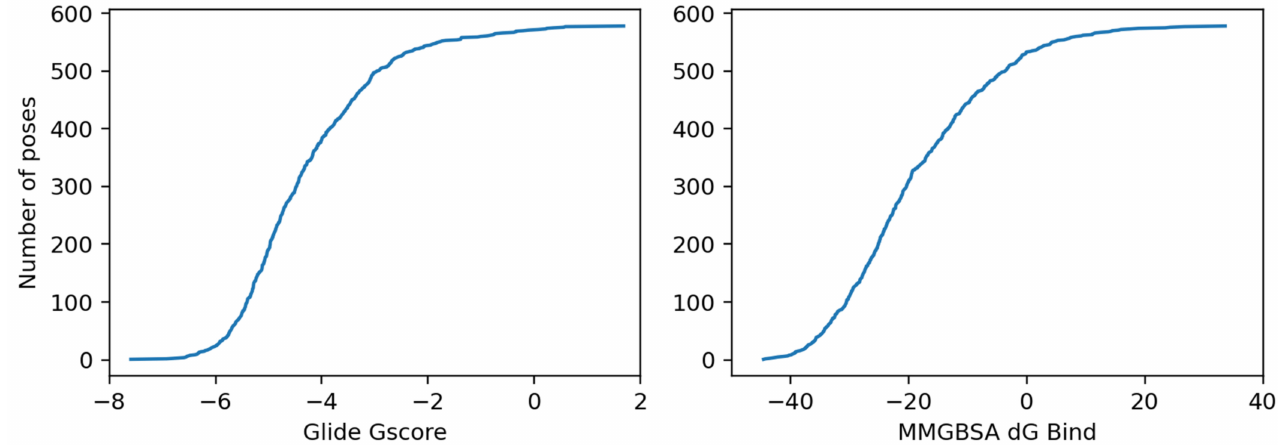
Figure 7. ( left ) Glide G-Score and ( right ) MMGBSA dG binding energy for the poses obtained on a set of ~130 drug-like molecules having a MW close to that of the studied compounds. All values are in